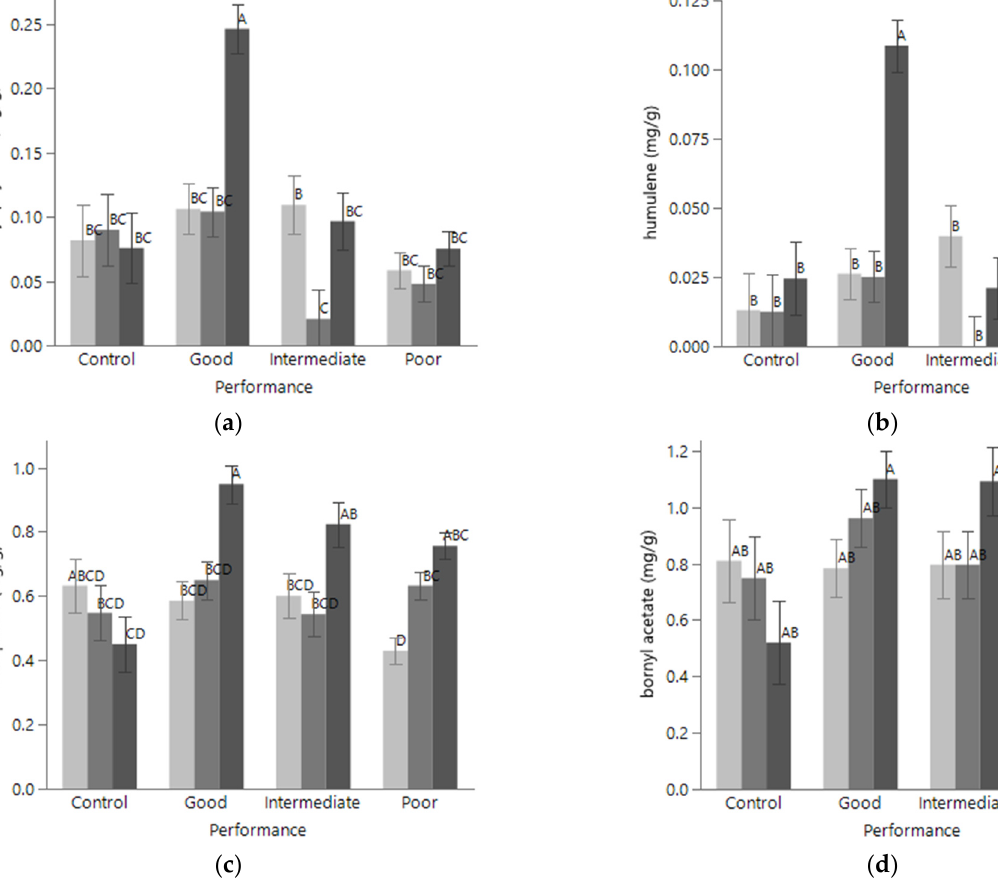
Figure 4. Significant differences in the concentrations of select terpenoids across Balsam woolly adelgid (BWA) infested groups over three sampling periods: light grey = pre-infestation, medium grey = 4 weeks after infestation, dark grey = 20 weeks after infestation. ( a ) Caryophyllene mg/g needle tissue, ( b ) humulene mg/g needle tissue, ( c ) camphene mg/g needle tissue, and ( d ) bornyl acetate mg/g needle tissue. Error bars show standard errors. Means with different letters are significantly different (Tukey’s HSD, α ≤ 0.05).